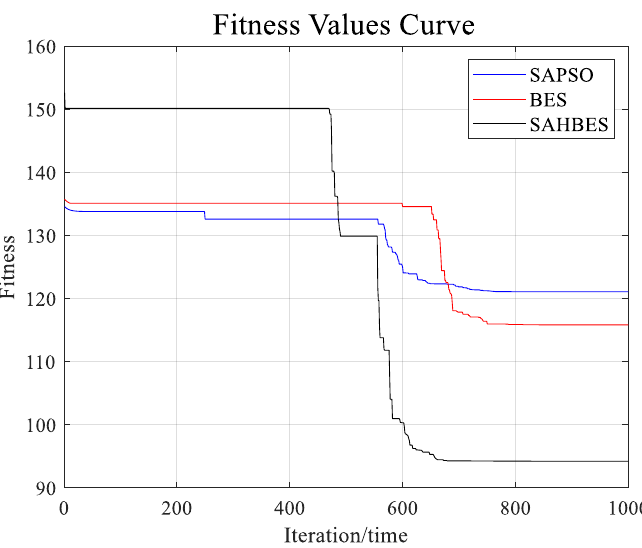
Figure 12. Comparison of the three algorithms’ fitness values of simulation II.